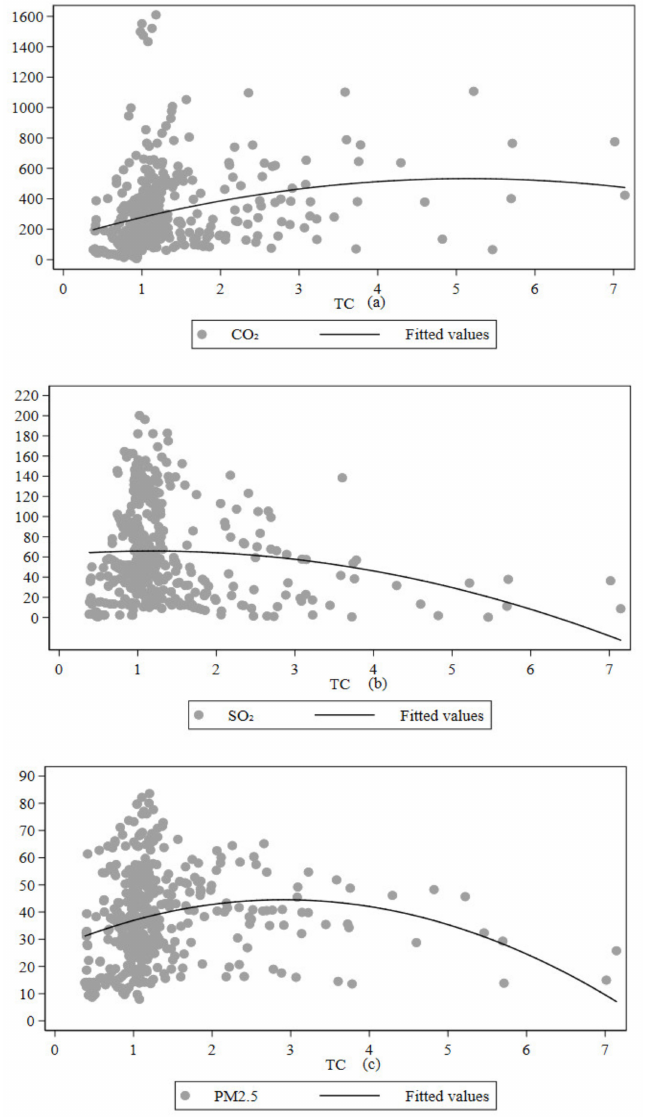
Figure 1. Scatterplot of technological progress and pollutants: ( a ) CO 2 and technological progress, ( b ) SO 2 and technological progress, ( c ) PM 2.5 and technological progress. The model is set up as